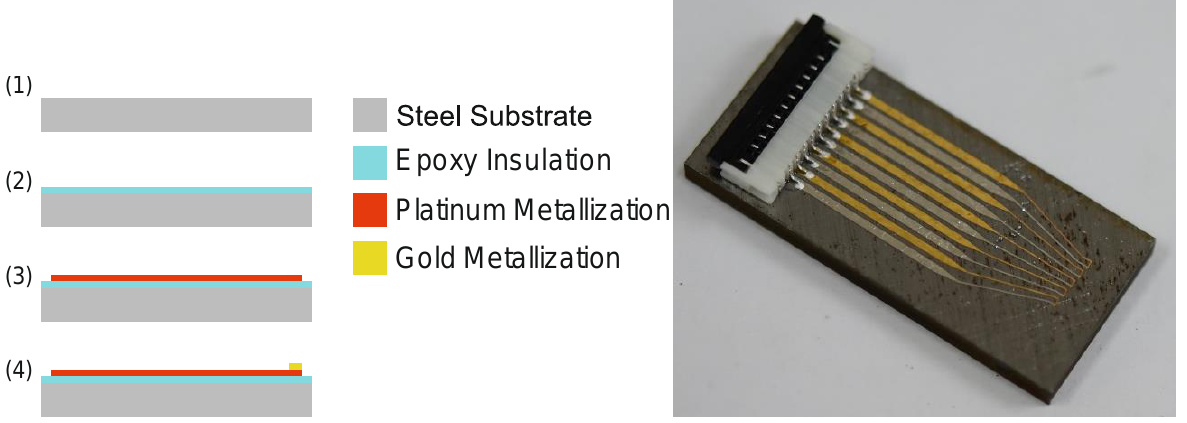
Figure 2. Fabrication process ( left ) and final workpiece ( right ).